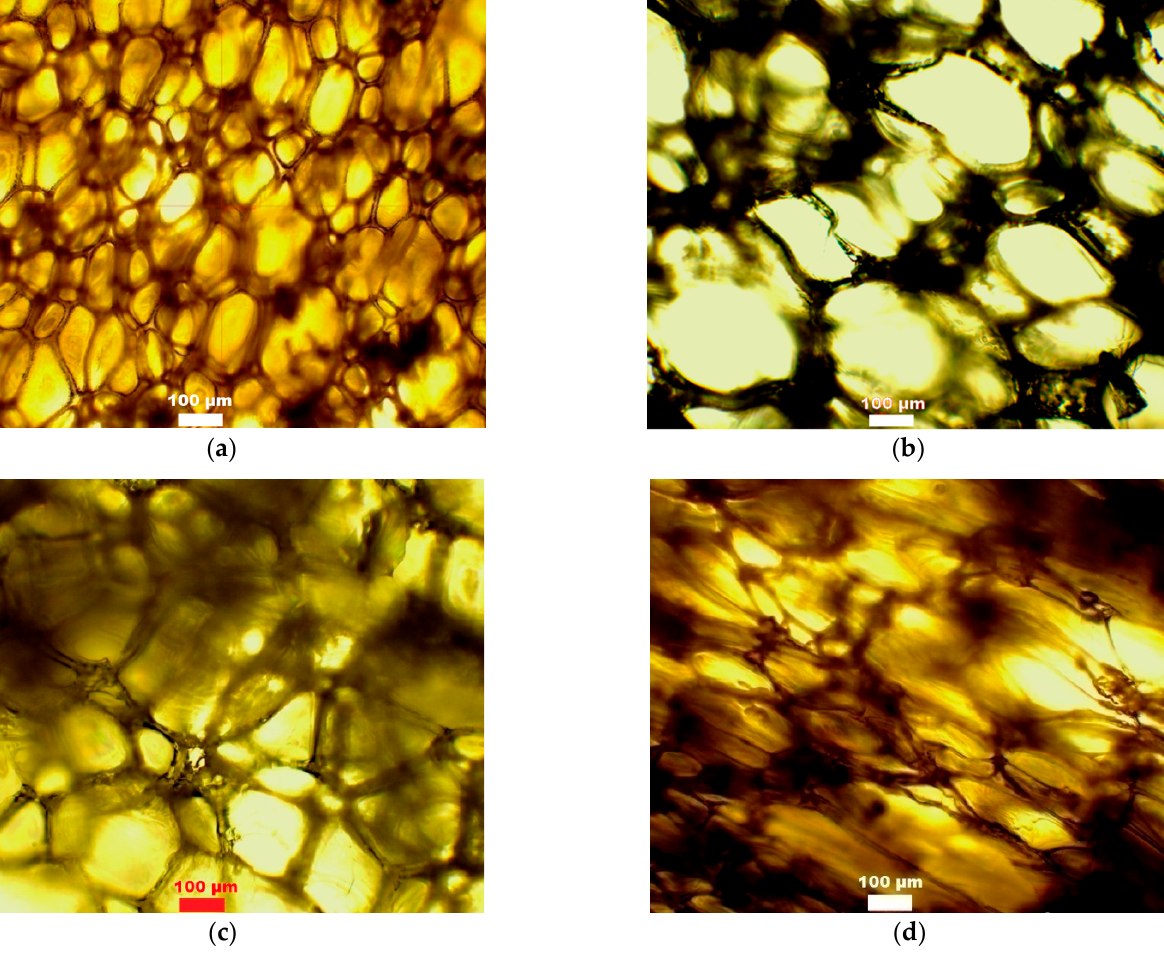
Figure 8. Optical microscopy images of foam obtained from polyols (CS + GL + GLYC) + EC ( a , b ) and (CS + GL) + EC ( c , d ),with 2% ( a , c ) and 3% ( b , d ) water content/100g of polyol. Table 6. Results of micrograph analyses.